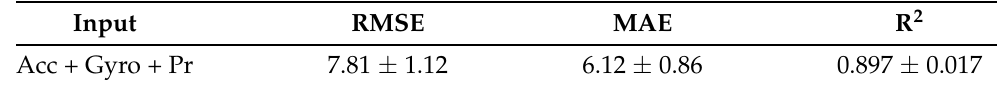
Table 5. HR (bpm) estimation performance.